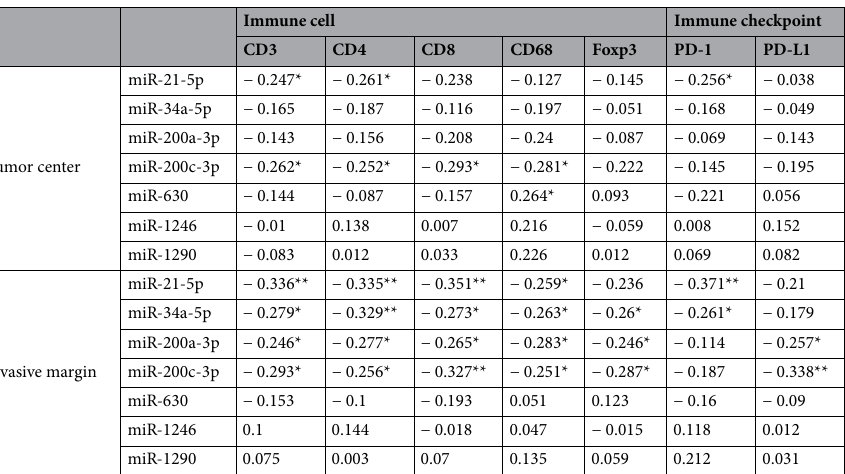
Table 2. Correlation coefficients between microRNA expression and tumor immune microenvironment (immune cell and immune checkpoint) in tumor center and invasive margin. Data are presented as Spearman’s correlation coefficient. * P -value < 0.05, ** P -value <